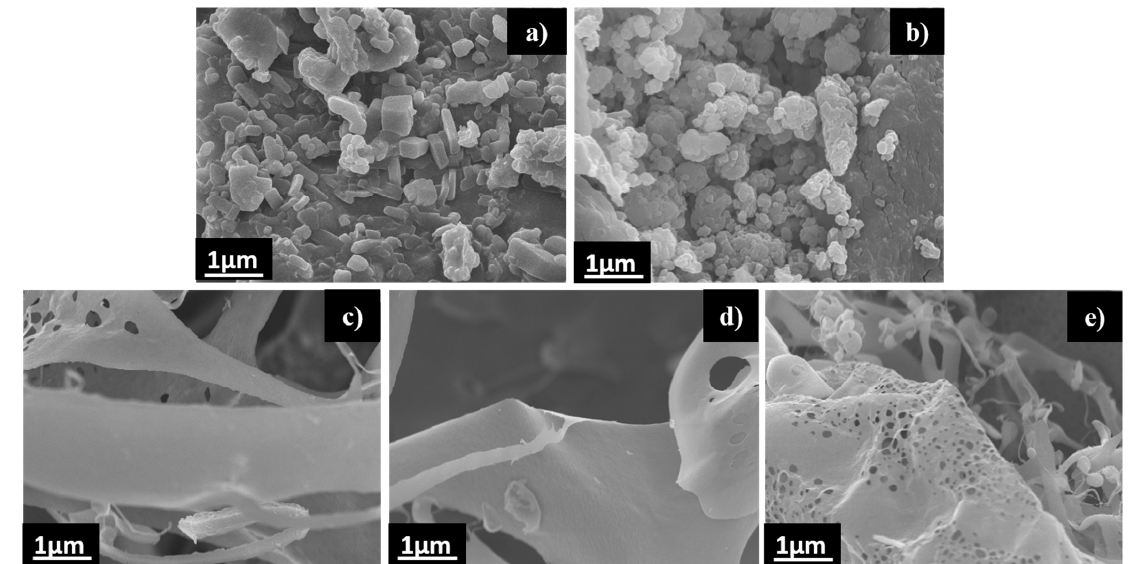
Figure 3. FE-SEM morphology: ( a ) pristine fucoidan, ( b ) pristine L-arginine, ( c ) Fuc-L-Arg (1:1) complex, ( d ) Fuc-L-Arg (1:2.5) complex, and ( e ) Fuc-L-Arg (1:5) complex.